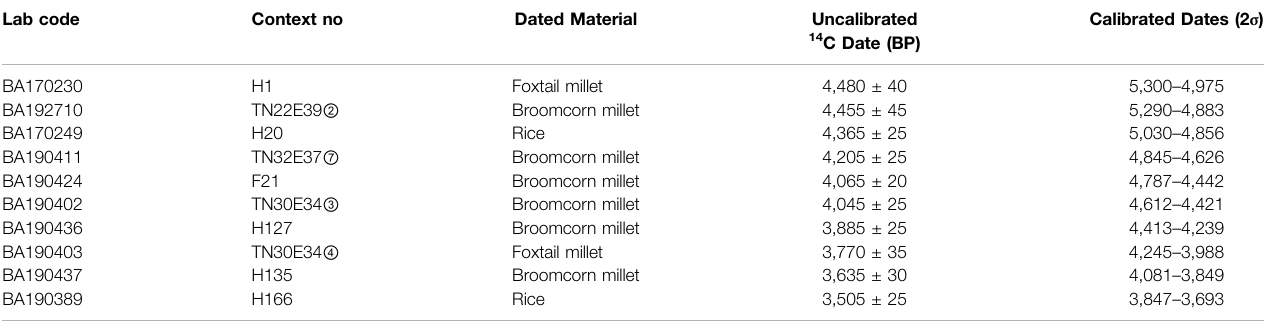
TABLE 1 | AMS Radiocarbon dating results of Neolithic contexts from the Guijiabao site. All dates were calibrated by OxCal v4.4.4, using the IntCal 20 Atmospheric curve (Reimer et al., 2020). Lab